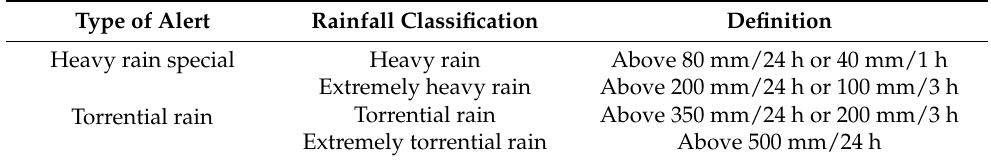
Figure 1. Location map of the Chenyoulan watershed. Table 1. Rainfall classification by the Central Meteorological Bureau of the Ministry of